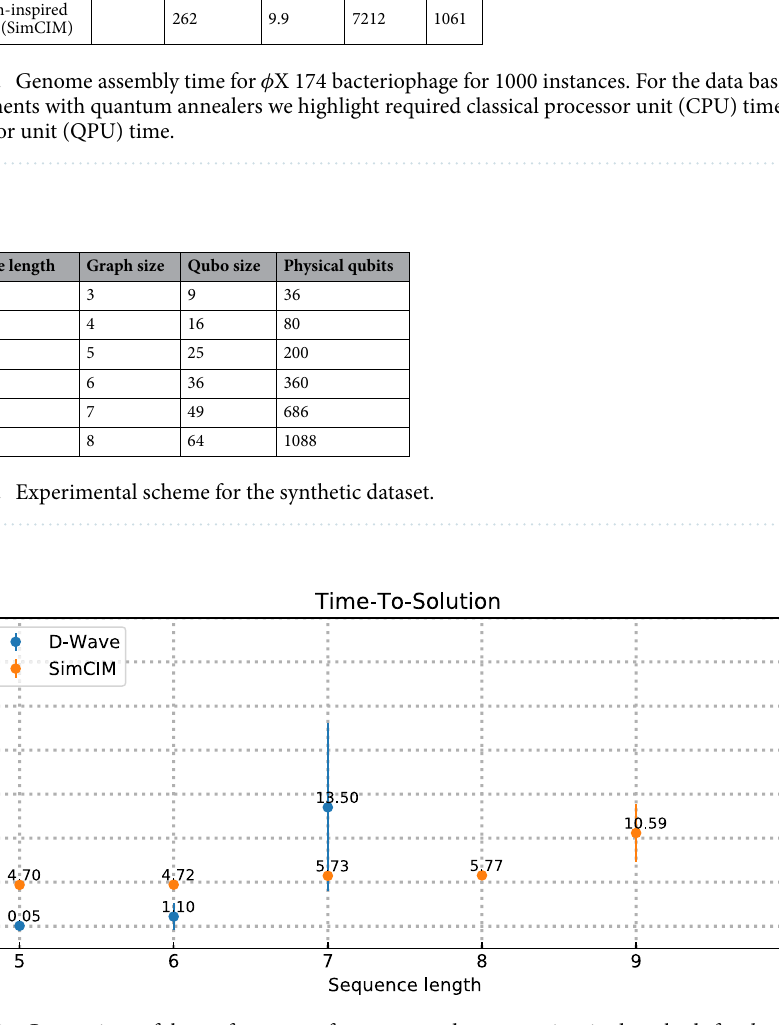
Figure 2. Comparison of the performance of quantum and quantum-inspired methods for de novo genome assembly based on synthetic data (10 problems were generated for every sequence length): we compare TTS for quantum device D-Wave and quantum-inspired optimization algorithm